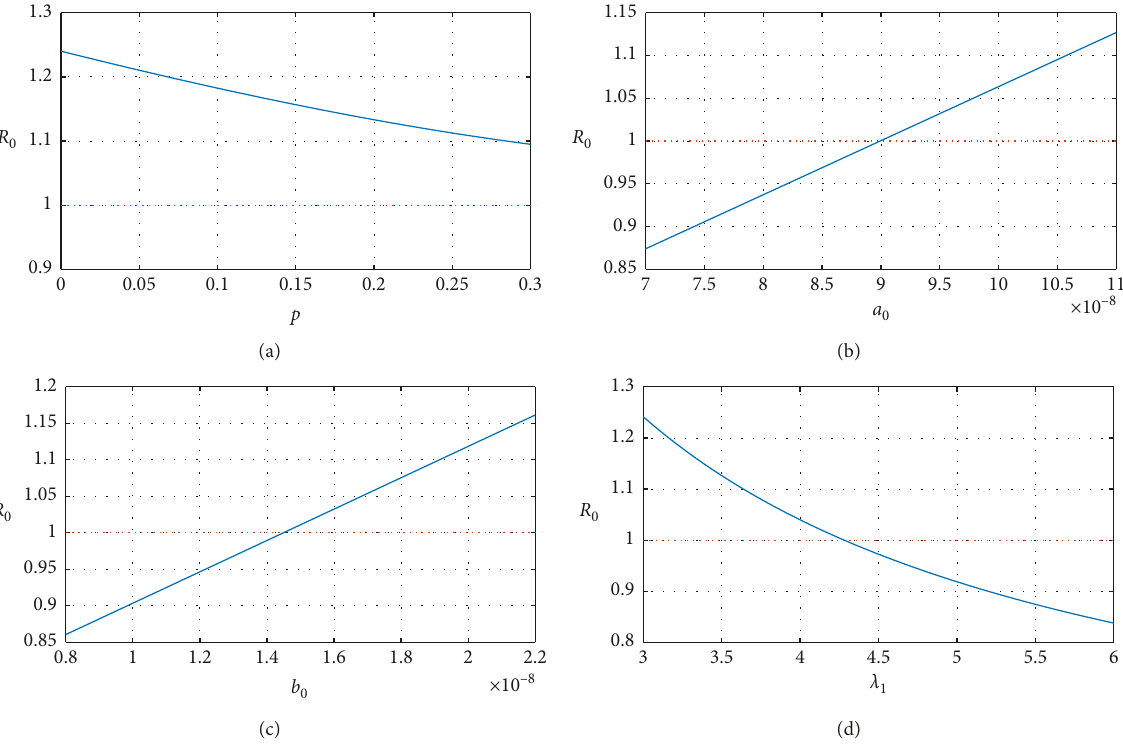
Figure 8: The influence of parameters on R contact rate of β